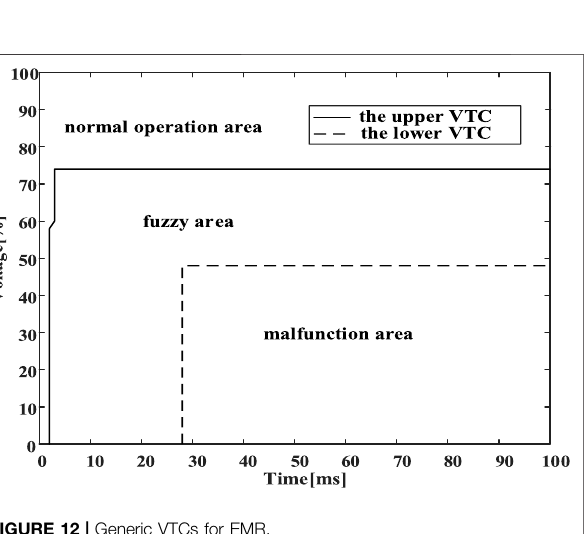
FIGURE 11 | Test results for R1 (0 ° PAJ). (A) Considering the frequency fl uctuation. (B) Considering the harmonic distortion. (C) Considering the magnitude variation in pre- and post-sag segment.